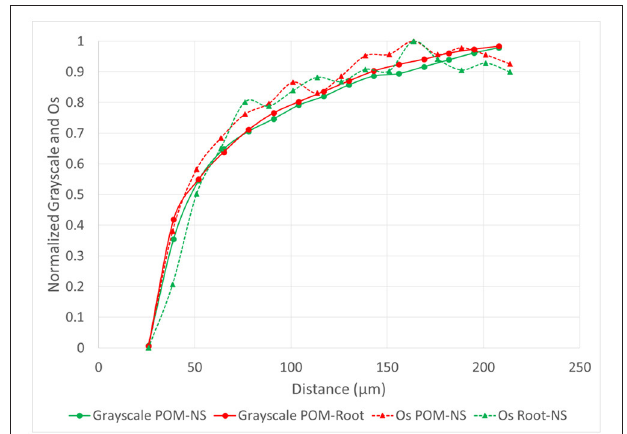
FIGURE 7 | Normalized Os values from Os stained samples ( n = 6) and grayscale values ( n = 96) from non-stained samples as a function of distance from POM-NS and POM-Root pores in the soil of the biologically based management.